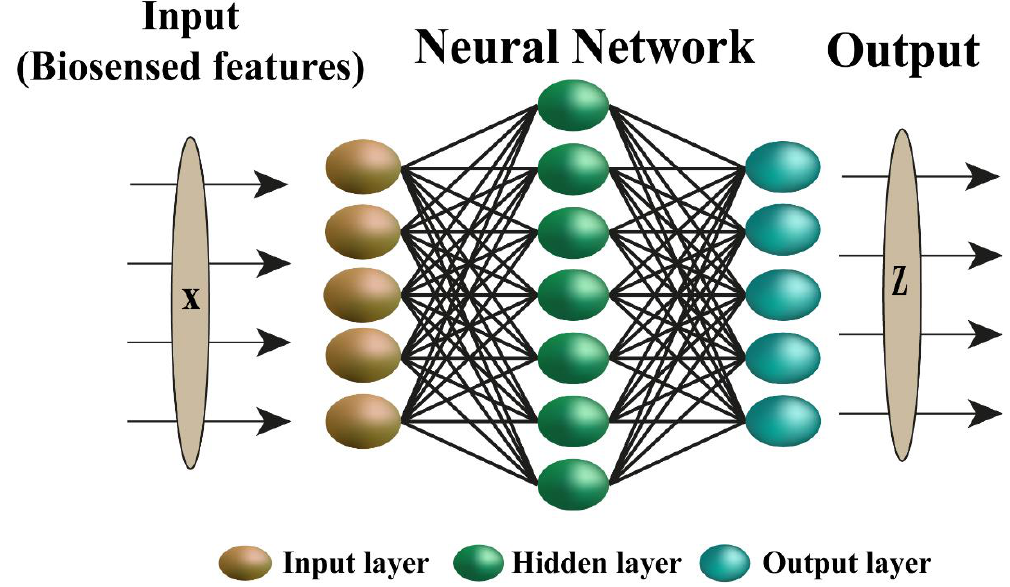
Figure 3. ANN common structure.